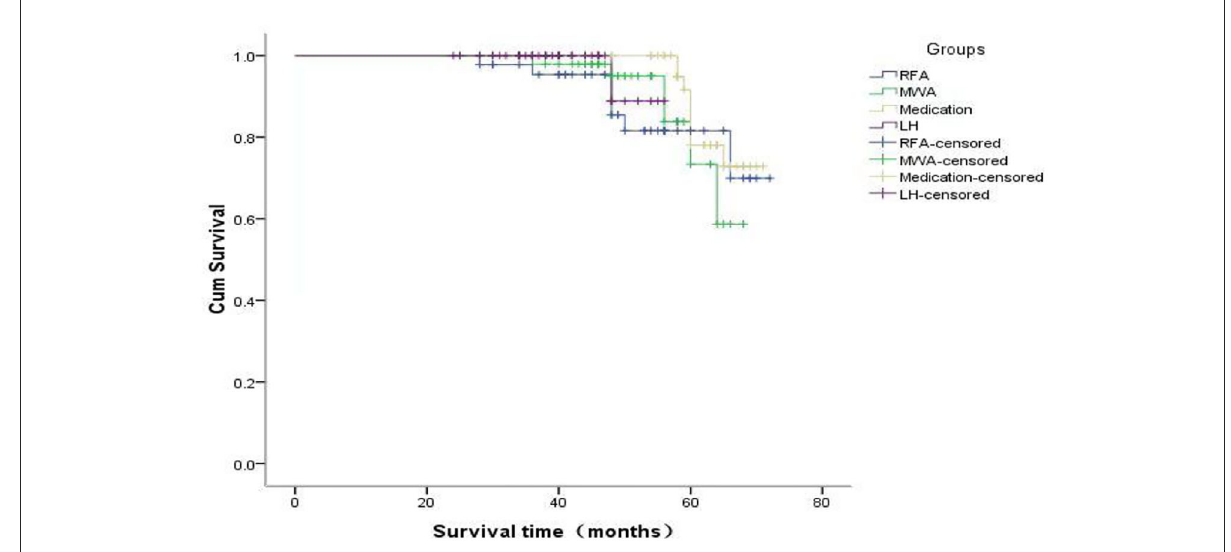
FIGURE2 The RFS analysis of the four groups of patients with different treatments.